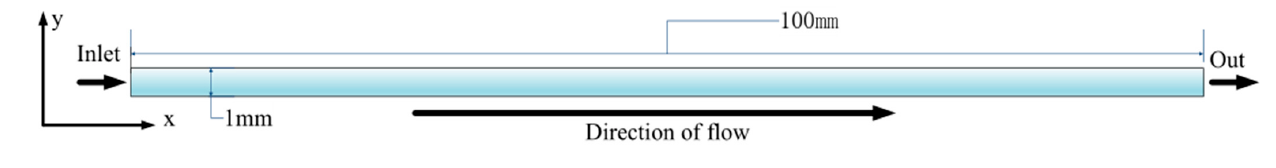
Figure 1. Geometric model.